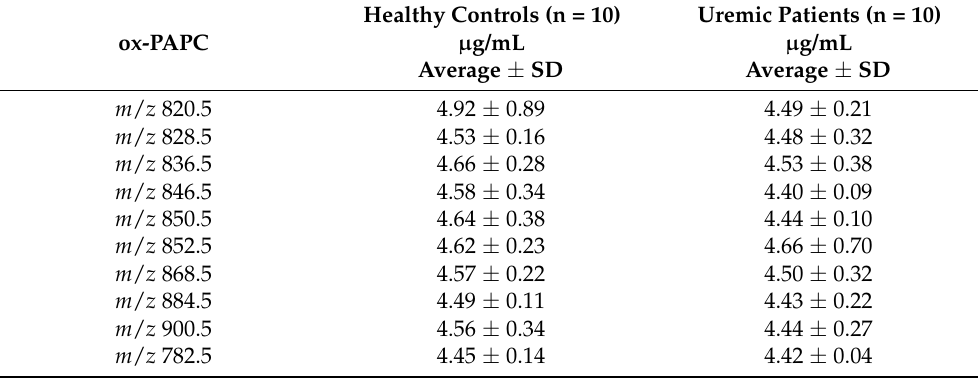
Table 3. Long-chain ox-PAPC product concentrations in LDL of healthy controls and uremic patients. Healthy Controls (n = ox-PAPC